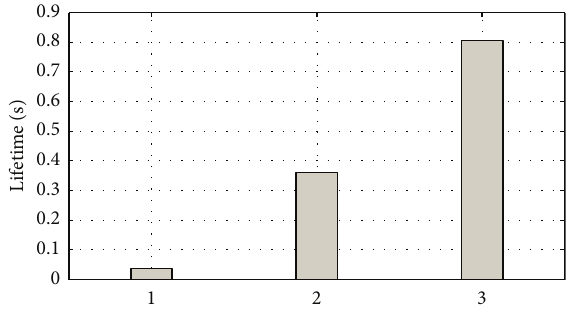
Figure 13: The maximization of the lifetime under integer optimiza- tion programming. (1) Upper-bounded lifetime. (2) Node-density control. (3) Partitioning link quality.